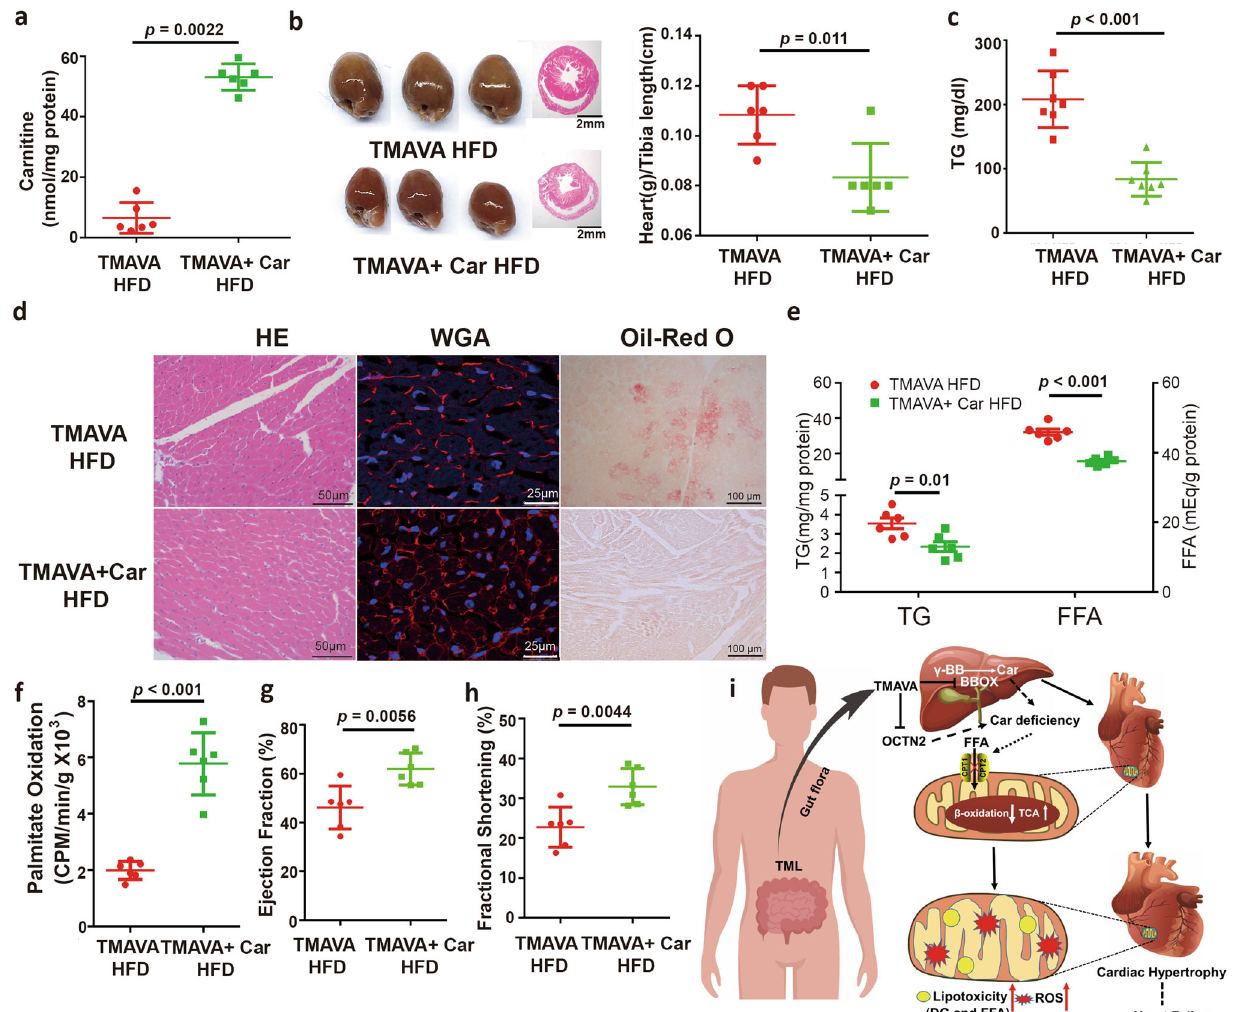
Fig. 6 Exogenous carnitine supplementation reverses TMAVA induced cardiac hypertrophy. TMAVA-treated mice [0.325% (m/v %) in the drinking water]. Mice were fed an HFD with or without 0.325% carnitine (m/v %) in the drinking water for 12 weeks in [( a – h )]. a Carnitine level in heart tissue was measured after 12 weeks of treatment ( n = 6). b The hearts from the carnitine-treated group (TMAVA + Car) group were smaller (left) and the ratio of heart weight to tibia length (right) was signi fi cantly decreased in that group ( n = 6/group). c Plasma TG was decreased in the carnitine-supplemented mice ( n = 7). d H&E (left), WGA (middle), and Oil-red O (right) staining revealed myocardial cells with reduced hypertrophy and decreased neutral triglyceride deposition in the hearts of mice treated with TMAVA + Car. e Myocardial TG and FFA contents were decreased in the group with carnitine treatment ( n = 6). f Cardiac fatty acid β -oxidation activity was measured ex vivo in control and TMAVA-treated and TMAVA + Car-treated mice using 3 H-palmitic acid ( n = 6). g , h Ejection fraction ( g ) and fractional shortening ( h ) were assessed by echocardiography in the TMAVA and TMAVA + Car mice